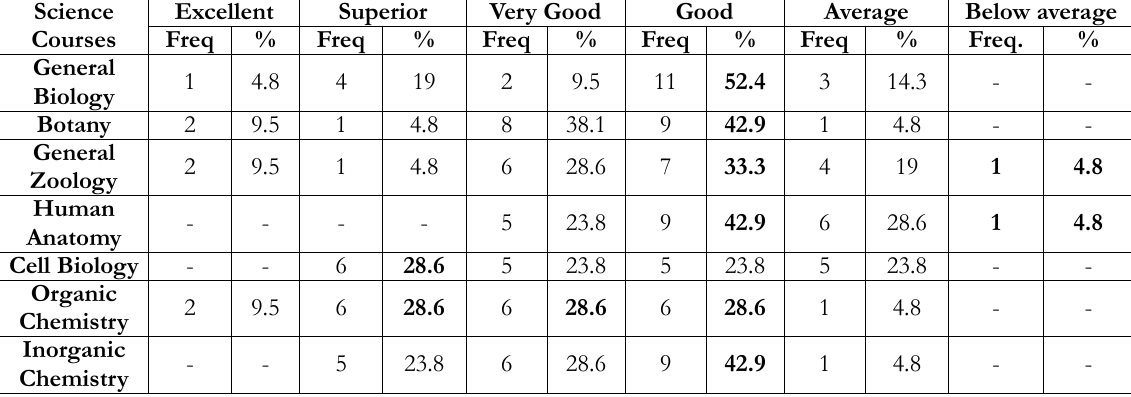
Table 4. The Respondents’ Academic Performances in